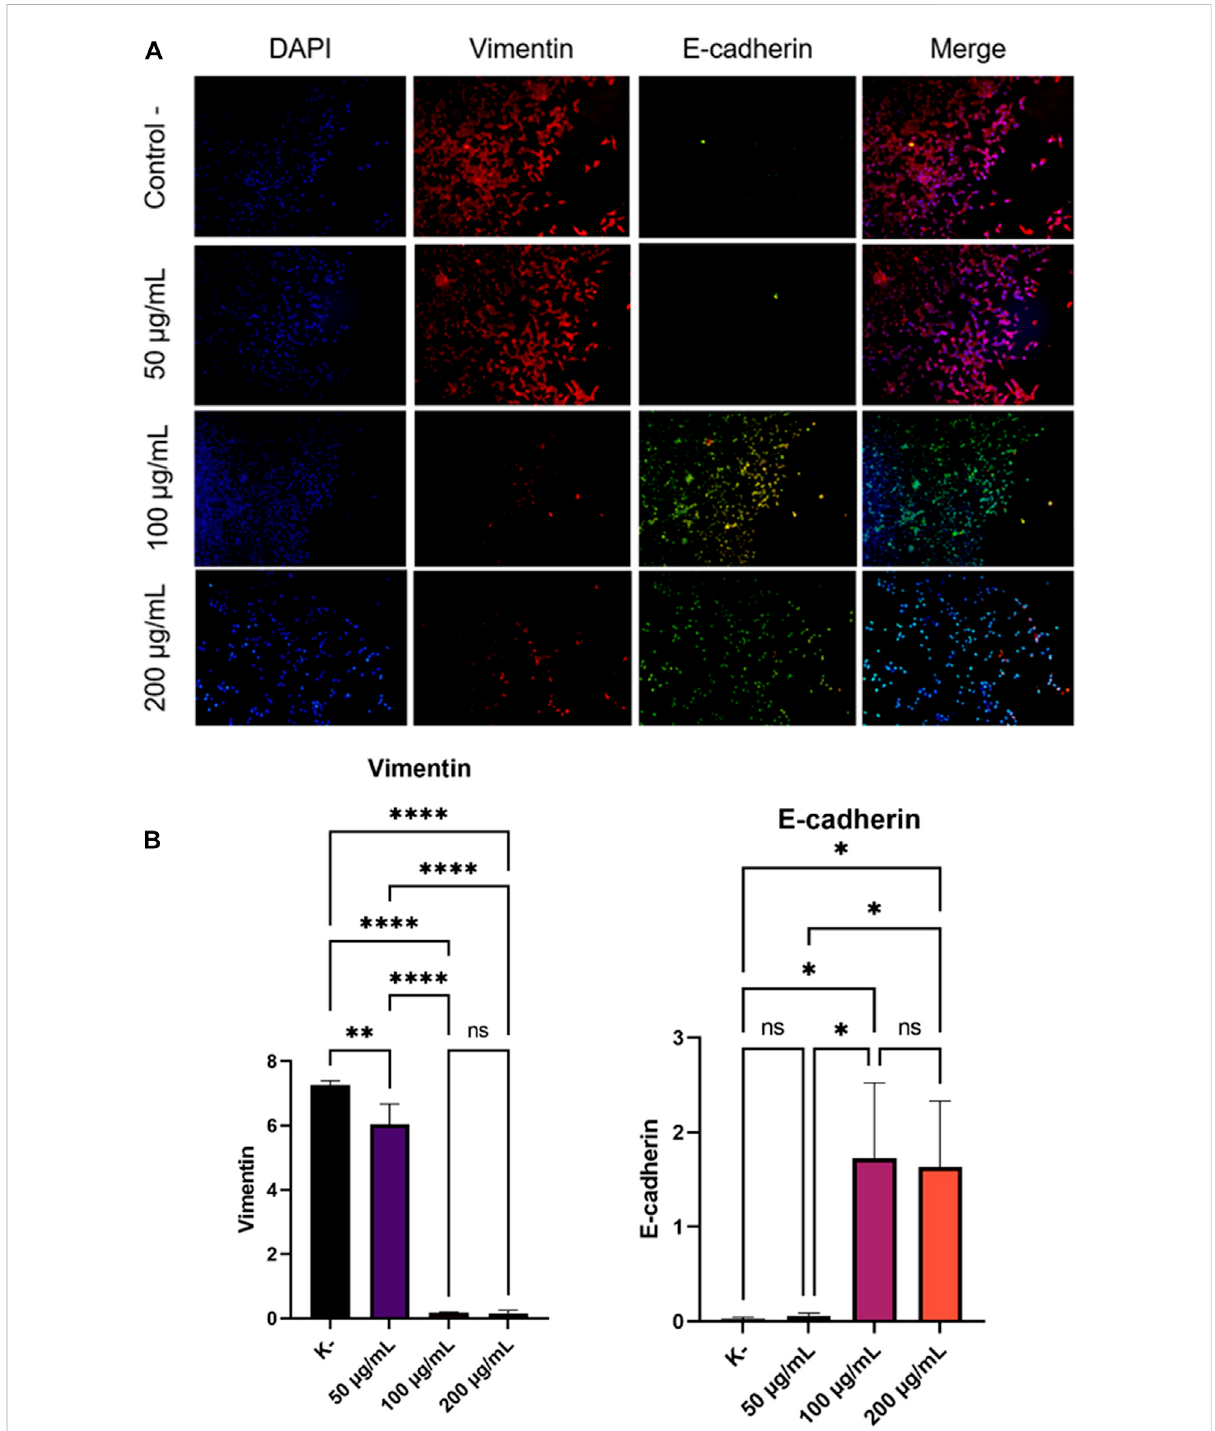
Decreased expression of Vimentin and increased expression of E-Cadherin after treatment with various doses of C. racemosa extract were observed with immuno fl uorescence. (A) Expression of Vimentin (red) and E-Cadherin (green) compared with DAPI (blue) on immuno fl